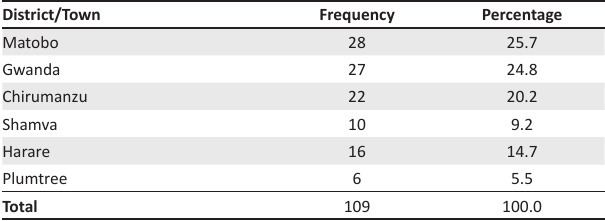
TABLE 2: Frequency of responses. District/Town Frequency